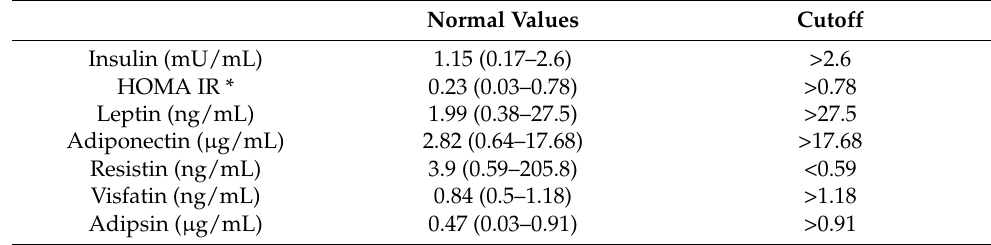
Table 1. Values for insulin, HOMA IR, and adipocytokines obtained in serum samples from 69 metabolic healthy Mexican women (reference